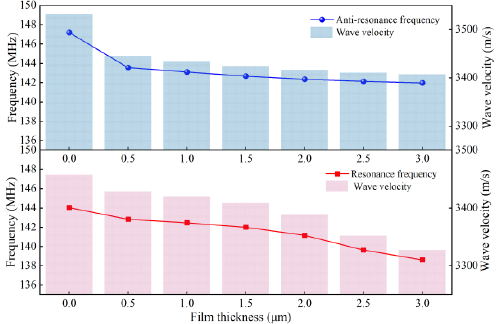
Figure 8. Thickness-frequency and wave velocity characteristics of PIB Figure 8. Thickness ‐ frequency and wave velocity characteristics of PIB film.